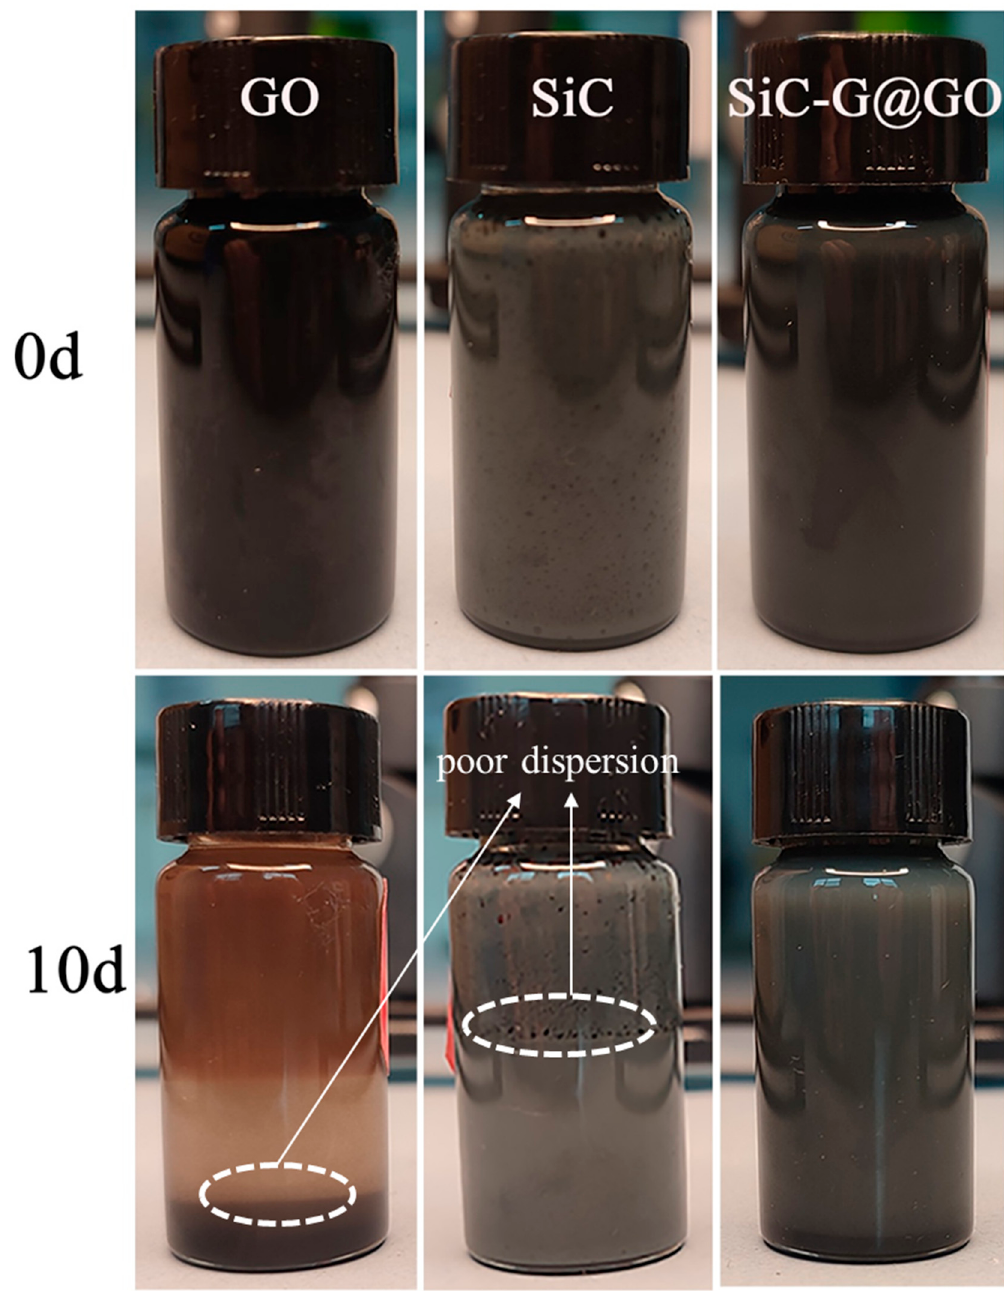
Figure 9. SiC, GO, and SiC-G@GO: dispersion stability in EP.